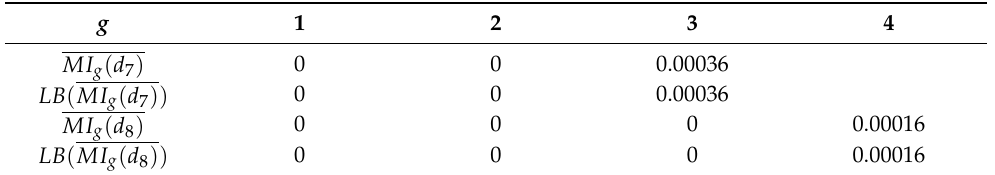
Table 4. Numerical results of Example 4.